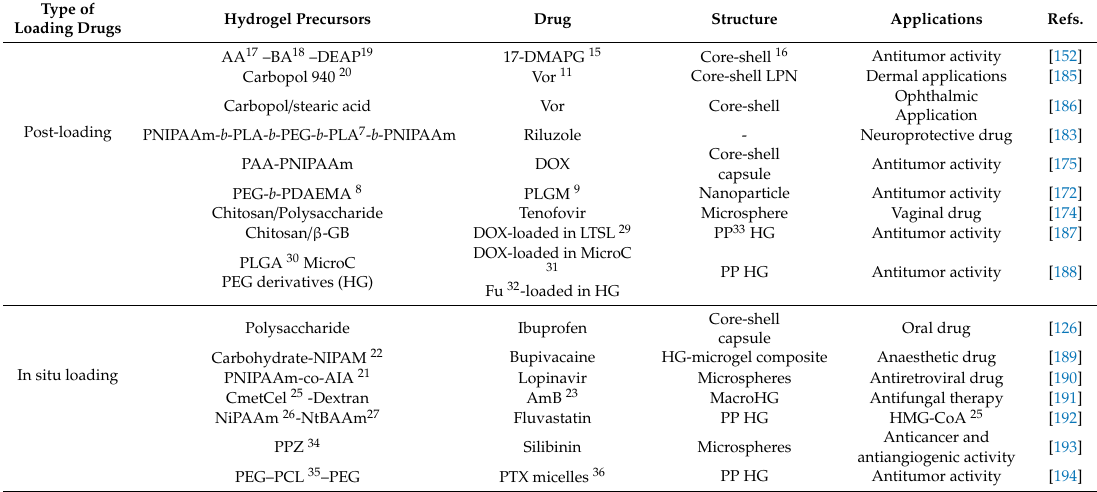
Table 2. Examples of HGs with di ff erent routes drug immobilization of and their structures and